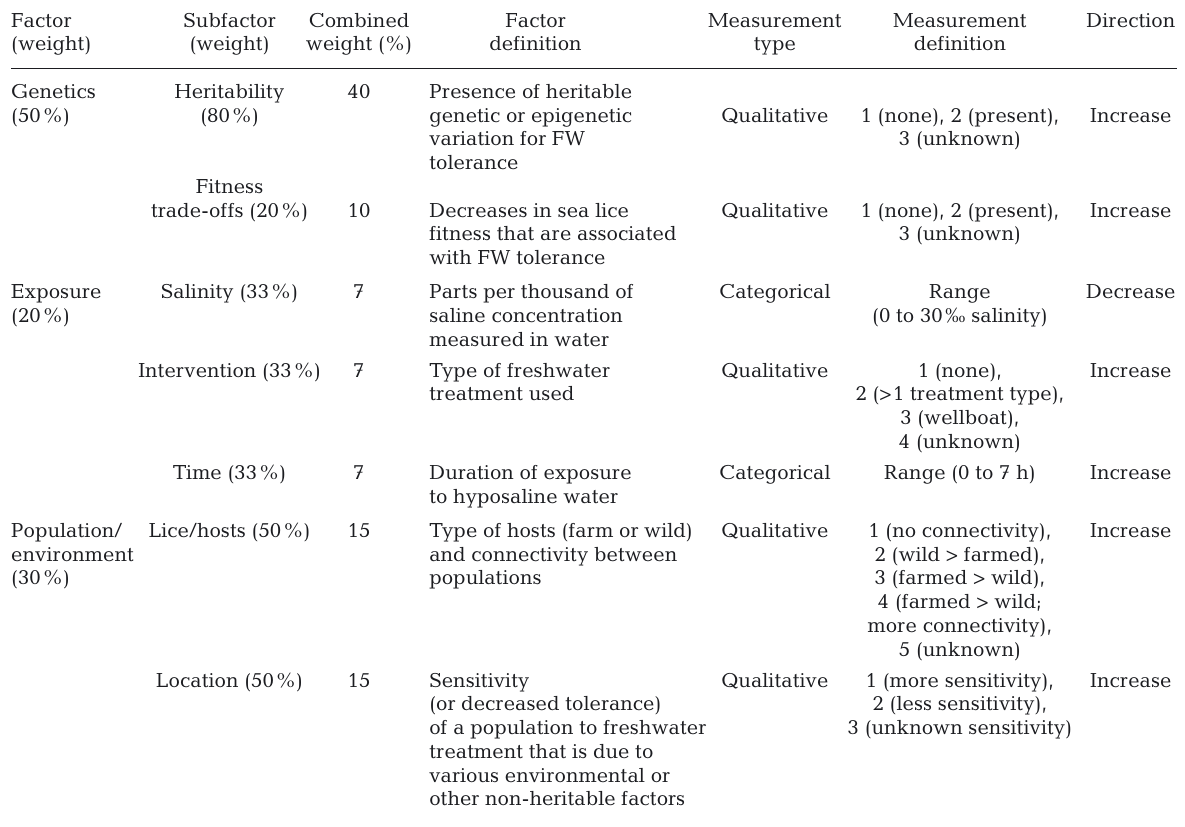
Table 2. Selected factor and subfactors (based on Ljungfeldt et al. 2017, Groner et al. 2019, Sievers et al. 2019, and expert opin- ion [M. Andrews]), for use in our Visual PROMETHEE example to evaluate risk ranking effect of these factors for sea lice evolving tolerance to freshwater (FW). Assigned weights are author-selected and are used to demonstrate how to incorporate overall (combined) versus individual factor and subfactor weight components. Combined weights refer to combining the